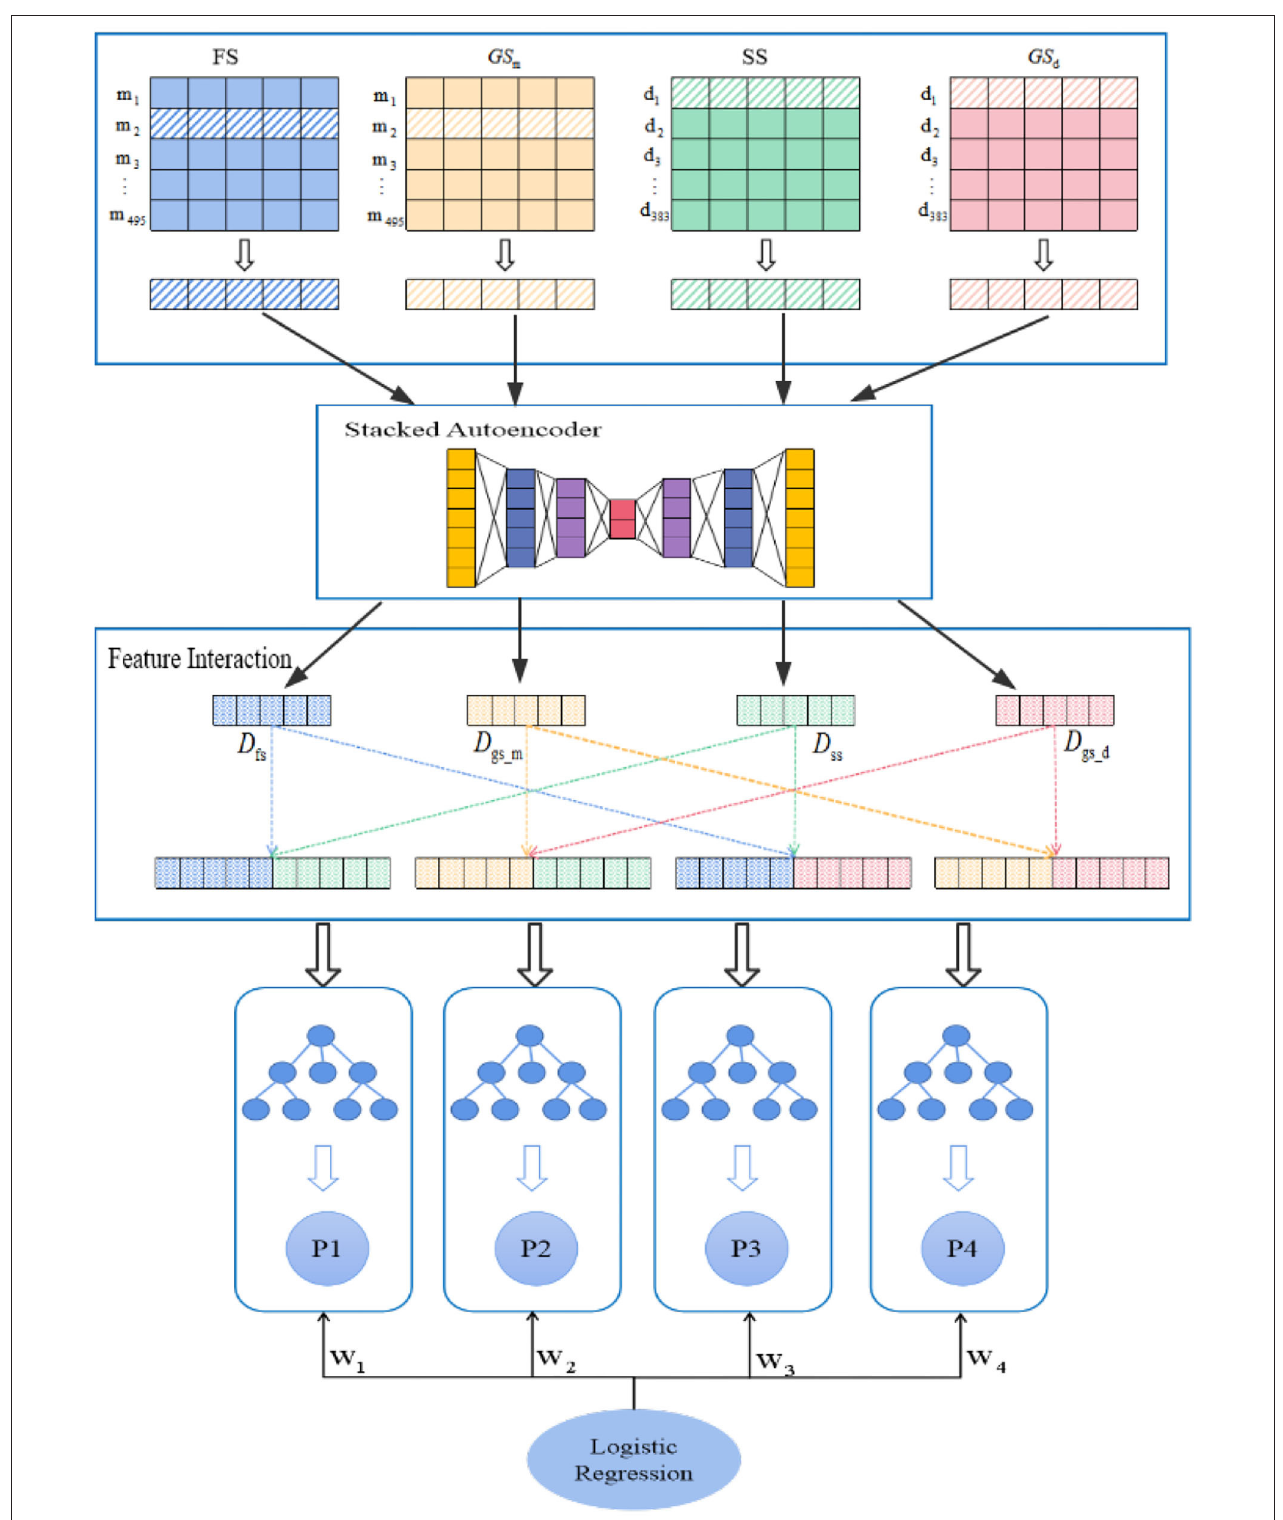
FIGURE 1 | Flowchart of PMDFI model to predict potential microRNAs (miRNAs)–diseases associations. The model can be divided into four parts: data set collection and processing, high-order feature extraction, feature interaction, and an integrated learning model. First, we gather miRNA–disease associations from HMDD v2.0, and form the similarity matrix between miRNA and disease; second, we adopt a stacked autoencoders to extract high-order features; then, we use the interaction features layer to learn the interaction between different features. Finally, we combine multiple random forest (RF) with logistic regression to predict potential miRNA–disease